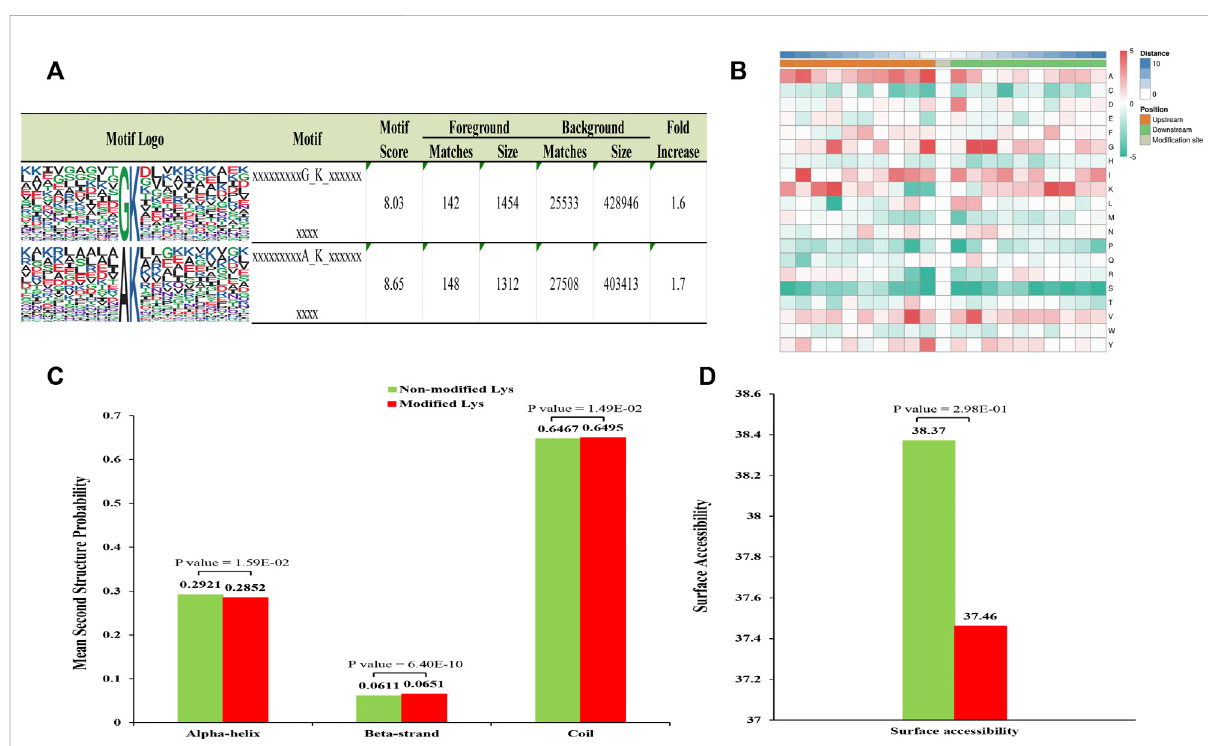
Analysis of related properties of Klac peptides in F. occidentalis . (A) Analysis of speci fi c amino acid enrichment ± 10 fl anking the Klac site (position 0). Lactylation motifs were constructed using the MOMO program. The central K (position 0) represents lactated lysine. Letters of different heights represent the frequency of occurrence of a particular amino acid. (B) The heat map represents the degree of enrichment of amino acids aroundtheKlacsite.Redindicateshighfrequencyandgreenmeanslowfrequency. (C) Identi fi cationofthefrequencyofoccurrenceofdifferent secondary structures ( α -helix, β -strand and coil structures) in the resulting Klac proteins. (D) Surface accessibility of predicted Klac